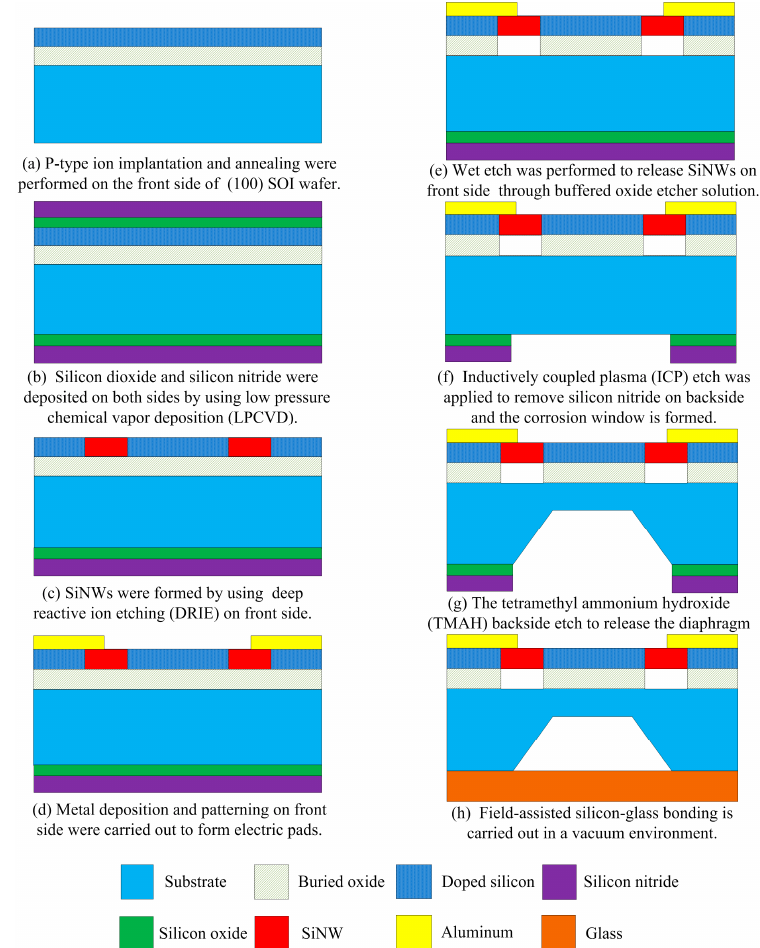
Figure 8. Process flow of the proposed SiNW piezoresistive pressure sensor (the drawing is not to